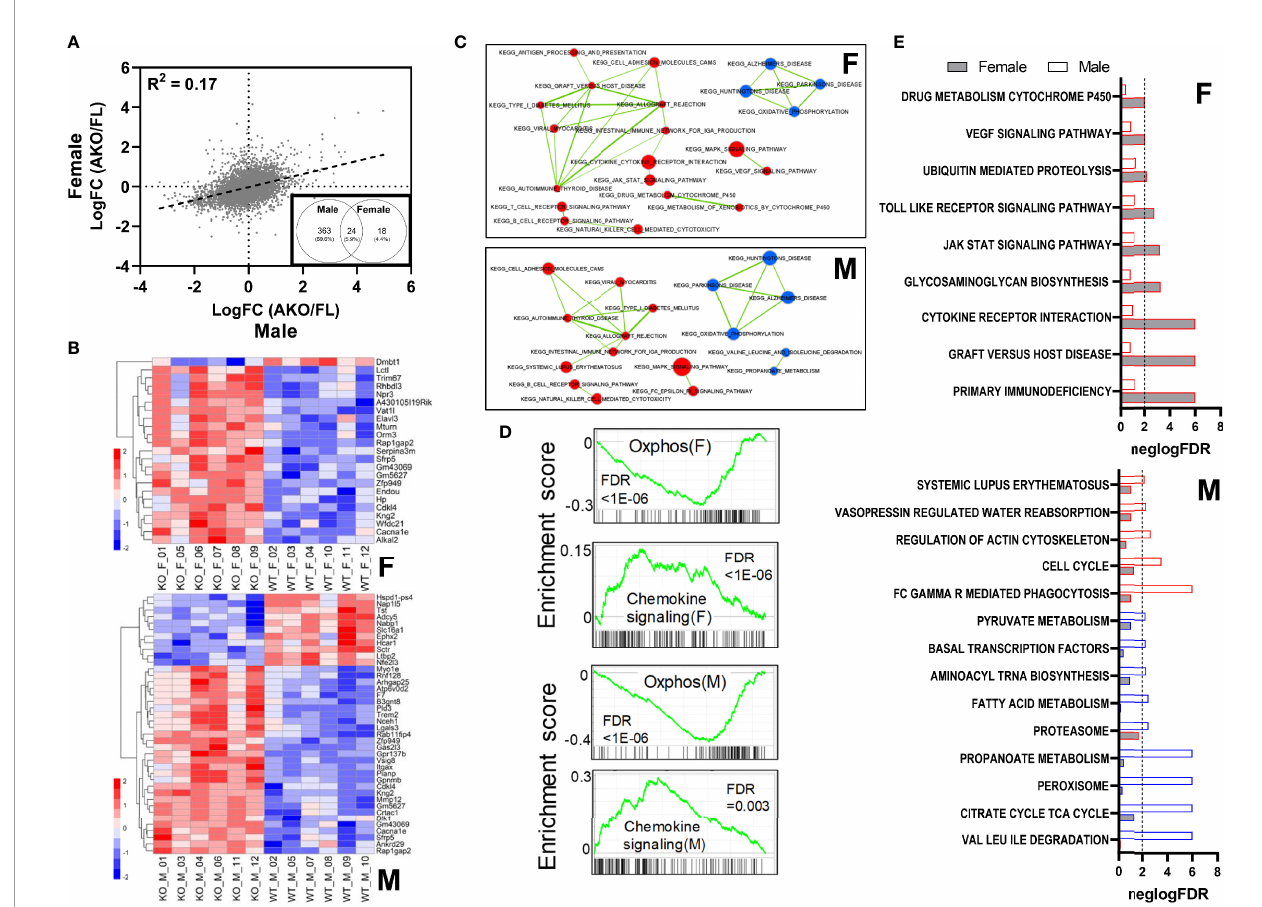
FIGURE 7 | Loss of adipocyte STAT5 results in sexually dimorphic gene expression changes within subcutaneous WAT. Inguinal WAT was collected from male and emale STAT5 AKO and fl oxed (FL) control mice at 6 weeks of age, and isolated mRNA was subjected to RNA-sequencing analysis. (A) Scatterplot showing correlation between female and male gene expression changes resulting from adipocyte-speci fi c loss of STAT5 (LogFC = Log fold change). The black dashed line is the trend line, and the correlation coef fi cient (R2) is shown. Inset: Venn diagram of 405 differentially regulated genes in male and female mice (AKO/FL) at threshold adjusted p-value equal to 0.05, expressed as numbers of genes and percentages of total regulated genes. (B) Heatmaps of expression levels of top differentially regulated genes in female (F) and male (M) samples. For females, genes with an adjusted p-value ≤ 0.1 and ≥ 2 or ≤ -2-fold differential gene expression, and for males, genes with adjusted p-value ≤ 0.01 and ≥ 2 or ≤ -2-fold differential gene expression are plotted. Heatmaps are row-normalized with lower gene expression shown in blue and higher gene expression in red. KO labels refer to STAT5 AKO mice and WT to STAT5 fl oxed mice. (C) Enrichment maps of signi fi cant pathways identi fi ed from GSEA (FDR ≤ 0.05) that share gene members. Upper and lower panels show signi fi cant pathways in females and males, respectively. Pathways upregulated in knockouts are colored in red, and downregulated pathways in blue. Thickness of lines connecting pathways is proportional to the extent of gene sharing between them. Pathways with no shared genes are not shown. (D) Enrichment scores of selected pathways signi fi cantly altered in both females and males, as determined via GSEA. The upper panels for females (F) or males (M) show enrichment plots for the ‘ oxidative phosphorylation ’ pathway, which was downregulated in STAT5 AKO mice of both sexes; bottom panel for each sex shows enrichment plot for the ‘ chemokine signaling ’ pathway which was upregulated in both males and females. Pathway enrichment p-values (FDR) are noted in each plot. (E) Pathways uniquely enriched in females (F) or males (M). For each pathway, the relative signi fi cance of enrichment (negative logarithm of the FDR) in females and males (gray and white bars, respectively) are plotted side by side, with the vertical dashed line representing an FDR of 0.01. Pathways upregulated in knockout samples are indicated by a red border and pathways downregulated in knockout samples are indicated by a blue